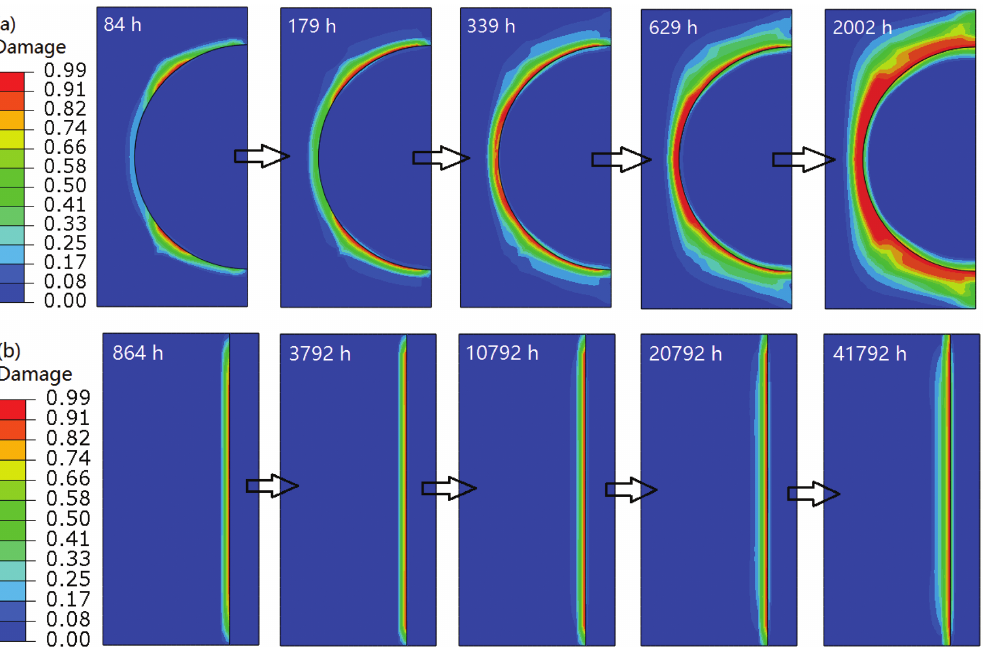
Figure 16: The evolution of damage contour with time of filler metal for semicircular defect R = 6mm (a) and straight defect L = 1.5mm